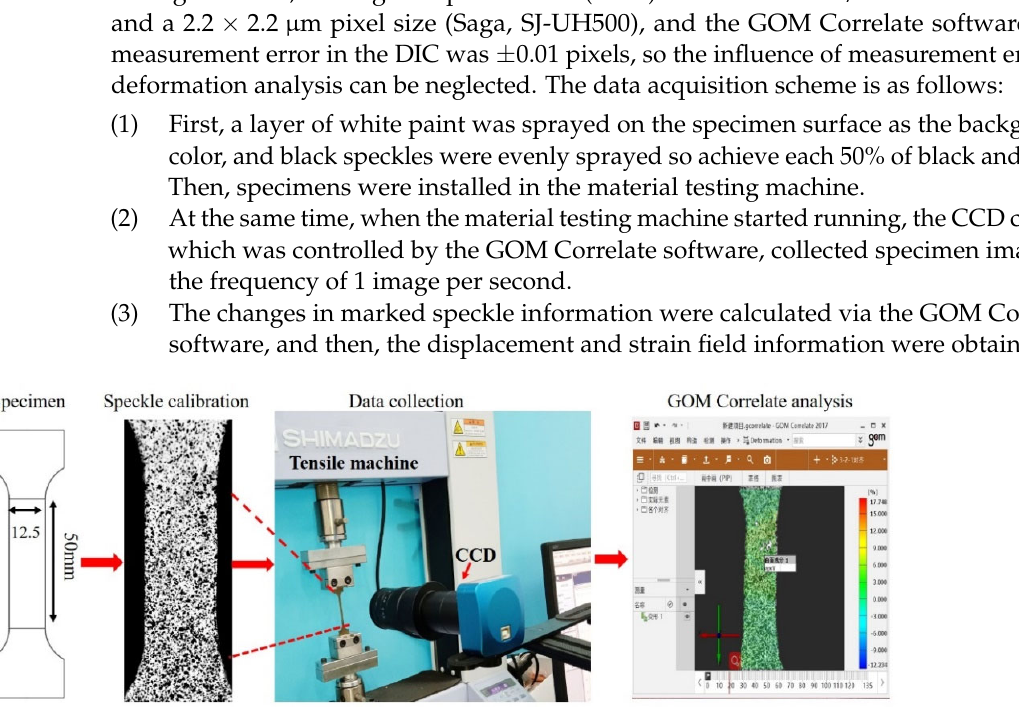
Figure 2. Analysis of the foil deformation process with the DIC technology.